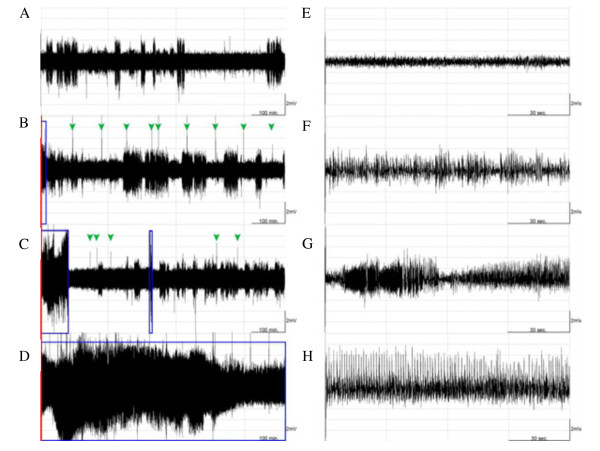
The effect of 100 Hz EA stimulation of bilateral Feng-Chi acupoints on the epileptic activities. Panels A, B, C and D respectively depict the EEG signals recorded from the naïve rats, the EA group, the pilocarpine group, and the PFS + EA + pilocarpine group, beginning from the dark onset of the dark period. Red lines indicate the time for pilocarpine administration (at the end of the 30-min EA stimulation). The blue boxes represent the epileptiform EEGs. Green arrowheads were the artifacts. The larger amplitudes, with EEG signals less than 2 mV, appeared in panels A, B and C were delta waves, which represent the state of slow wave sleep. Panels E, F, G and H were the enlarged figures which were respectively expanded the time scale from the panels A, B, C and D, and were recorded from the beginning of the dark period.